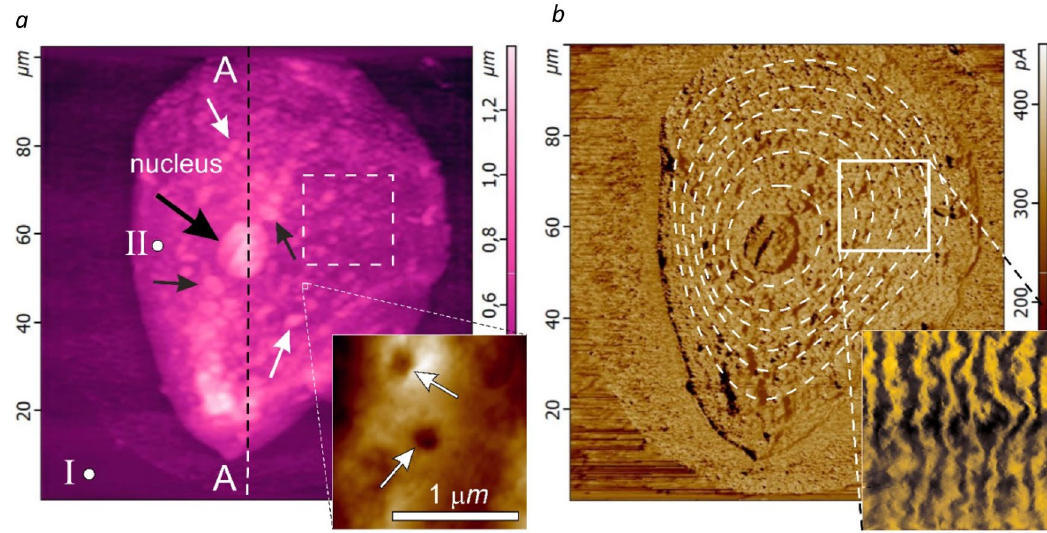
Figure 1. 100 × 100 μm raster images of the surface area of n + -epitaxial Si {111} with an adult living cell of human buccal epithelium located on it, obtained by contact AFM scanning in constant force mode: relief h(x, y) (the black arrow indicates the location of the nucleus, white arrows point to some organelles and micronuclei inside the cell, the inset shows the area with nanopores) ( a ), and distribution of lateral forces LF(x, y) (dotted line denotes the preferred orientation of the contrast of lateral forces, the inset demonstrates raster LF image of the selected 10 × 10 μm region of the cell surface area) ( b